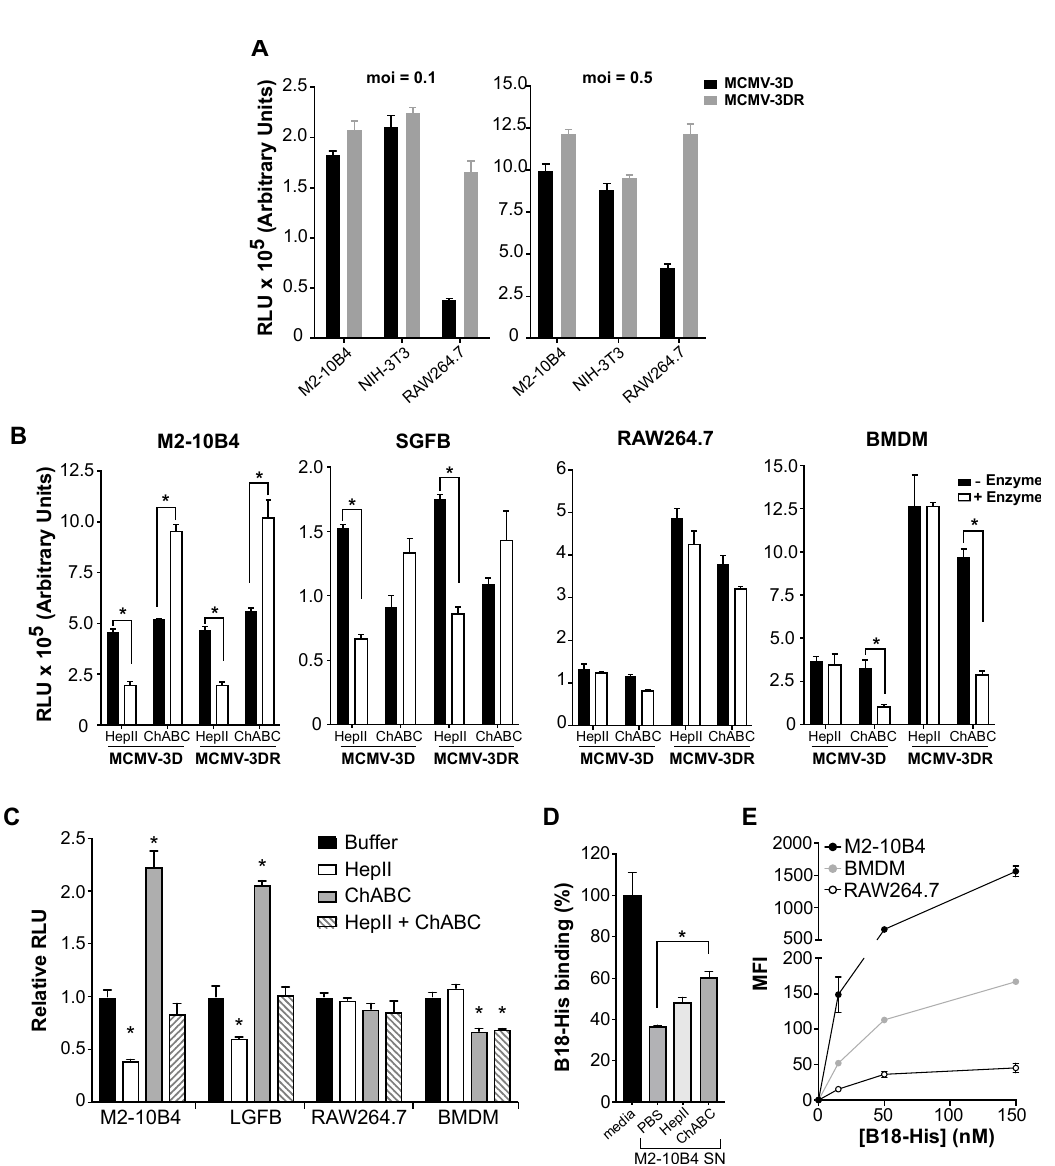
Figure 1. Mouse cytomegalovirus (MCMV) infection of diverse target cell types is differentially regulated by glycosaminoglycans (GAGs) in an MCK-2-independent manner. ( A ) MCK-2 deficiency impairs the MCMV infectivity of macrophages but not fibroblasts. Infectivity was defined as relative luminescence units (RLUs) recorded 18 hpi in 10 μ L of supernatant from the target cells indicated on the x-axis infected at the moi indicated above each graph with the Gaussia luciferase reporter viruses MCMV-3D (MCK-2 deficient MCMV, black bars) or MCMV-3DR (MCK-2 expressing wild-type MCMV, gray bars). M2-10B4 and NIH-3T3 are mouse fibroblast cell lines; RAW264.7 is a mouse macrophage cell line. ( B , C ) GAGs differentially affect target cell infectivity by MCMV. In B, the cell types indicated above each graph (SGFBs, primary mouse salivary gland fibroblasts; BMDMs, primary mouse bone marrow-derived macrophages) were pretreated with the GAG lyases indicated on the x-axis (HepII, heparinase II; ChABC, chondroitinase ABC), and then infected with viruses (moi = 0.1) as indicated below the x-axis. White bars, + Enzyme; black bars, - Enzyme (reaction buffer without enzyme). Infectivity was determined at 18 hpi as in panel A. In panel C, the effect of the GAG lyase treatments indicated in the inset on the infectivity of MCMV-3DR (moi = 0.1) for the target cells indicated on the x-axis (LGFBs, primary mouse lung fibroblasts) were analyzed as in panel B. Results are shown relative to the RLUs detected in the “Buffer” group (reaction buffer without enzyme) for each target cell type. ( D ) The MCMV infectivity of mouse M2-10B4 fibroblasts may be restricted by soluble